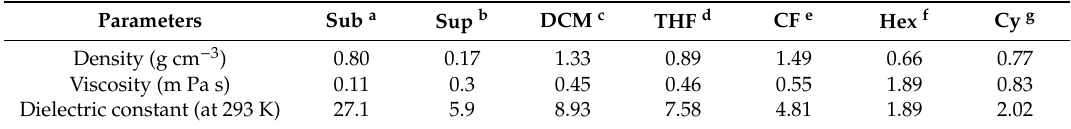
Table 3. Exemplification of the properties of nonpolar solvents and